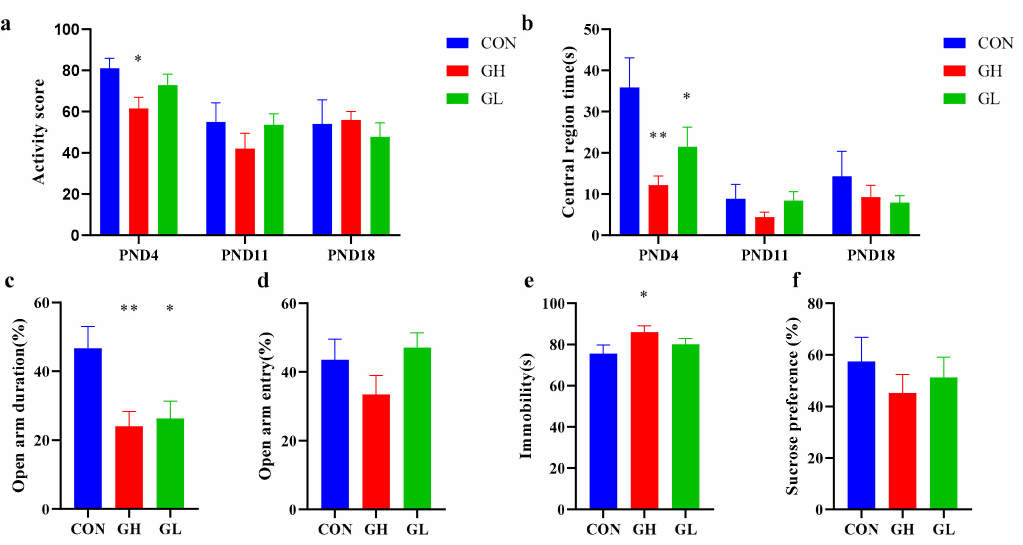
Figure 4. Results of postnatal behavior test in CON, GH and GL group. ( a ) Activity point in the OFT. ( b ) Central region times (s) in the OFT. ( c ) Open arm entry (%) in the EPM in PND6. ( d ) Open arm duration (%) in the EPM test on PND6. ( e ) Immobility times (s) in the FST on PND8. ( f ) Sucrose consumption ratio (%) in the SPT on PND21. * significant differences vs. CON group, p < 0.05. ** significant differences vs. CON group, p <